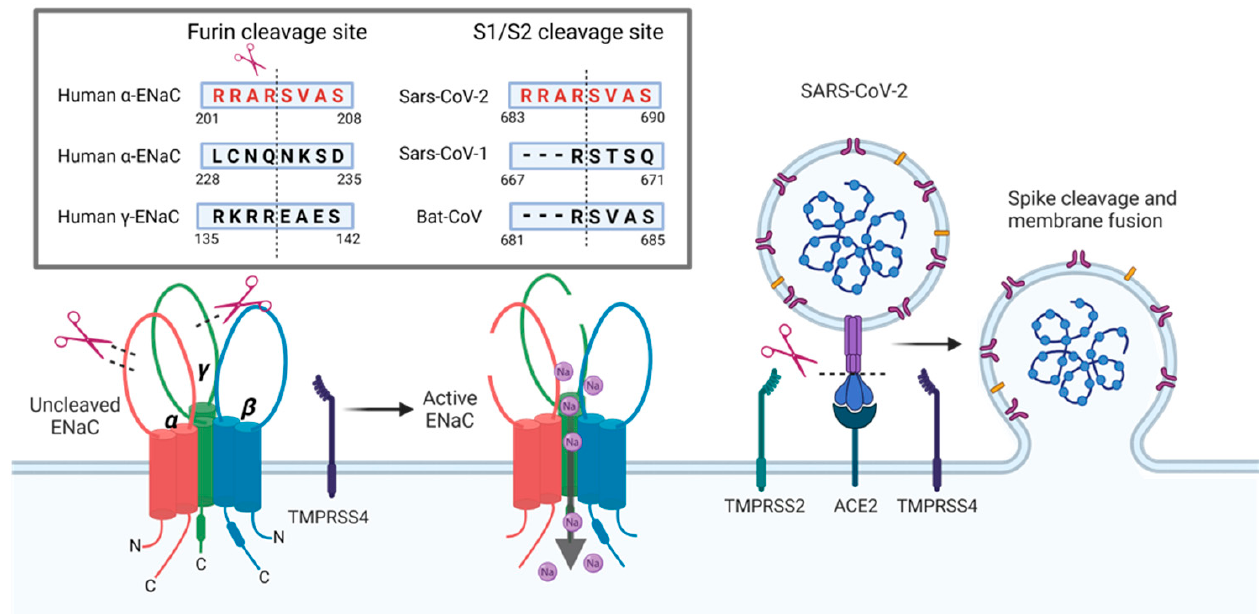
Figure 4. Furin cleavage sites for α - and γ -ENaC subunits and SARS-CoV-2 spike protein. Furin cleaves the α -subunit twice as well as the γ -subunit to fully activate the channel. Intriguingly, the SARS-CoV-2 spike protein has an identical 8 amino acid (aa) sequence as one of the furin cleavage sites of α -ENaC. Cleavage at this site increases SARS-CoV-2 spike’s affinity to the ACE2 receptor compared to SARS-CoV spike. SARS-CoV-2 spike protein is further cleaved by TMPRSS2 and TMPRSS4 to facilitate viral entry to the host cell. TMPRSS4 can also cleave γ -ENaC at a cleavage site that is distinct from the furin cleavage site. The occupation of host proteases by SARS-CoV-2 may reduce proteolytic cleavage of α - and γ -ENaC, which will impair Na + transport. Furin se- quences: human α -ENaC, aa201-208, SARS-CoV-2, aa683-690, SARS-CoV, aa667-671 and Bat-CoV,